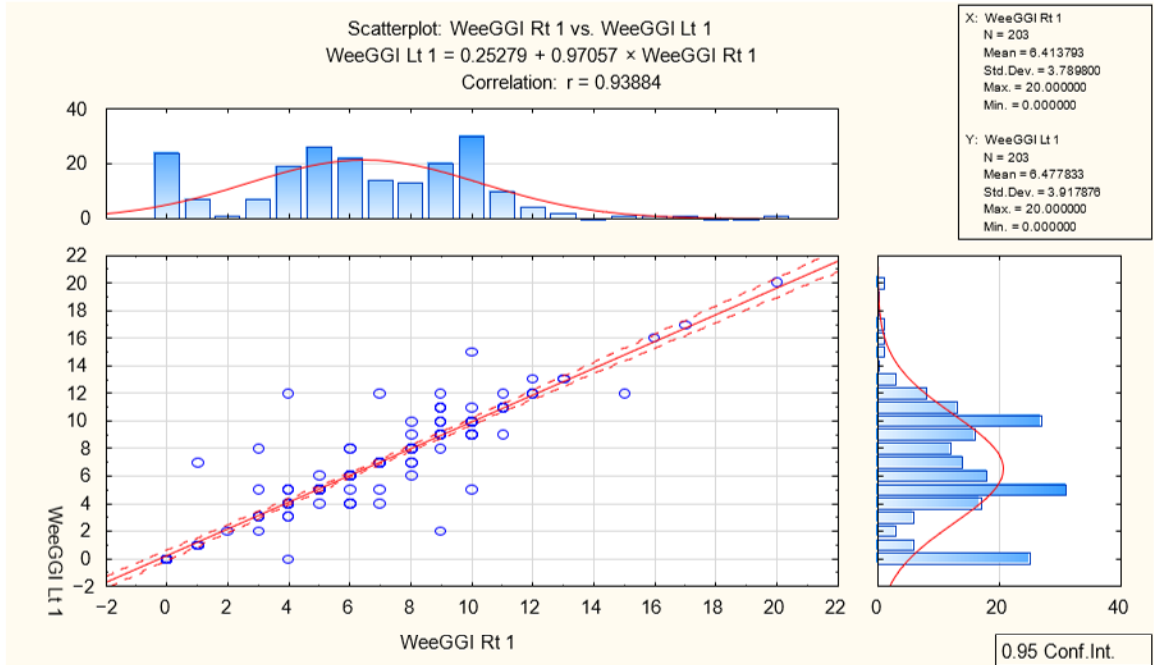
Figure 2. FPI-6 results from the right and left foot. WeeGGI gait analysis was measured during the same session as the foot postural index; patients independently walked barefoot on the hard floor for at least ten steps (Table 1). The WeeGGI mean was 6.44 ( n = 406, SD 3.84), which can be considered a deviation from the regular gait pattern. The right foot mean score was 6.41 ( n = 203, SD 3.78), and the left foot mean score was 6.47 ( n = 203, SD 3.91). The correlation for general gait analysis was r = 0.93, presenting very high impact of DDH on gait. Significant correlation was found between the right r = 0.97 and left r = 0.25 lower limbs. Gait analysis showed that DDH affects the right lower limb more than the left. The sign test revealed difference between the right and left lower limbs with a p -value of 0.88 ( p < 0.05). DDH affects the left lower limb more than the right during gait (Figure 3).